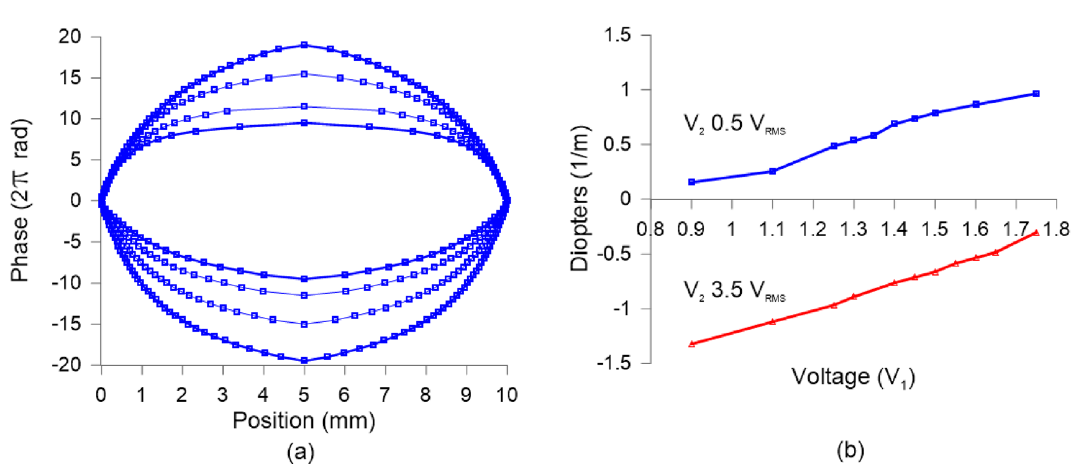
V V V V V V 1 = 1.25 , 2 = 3.5 , ( f ) 1 = 1.4 , 2 = 3.5 , ( g ) 1 = 1.55 , 2 = 3.5 ,